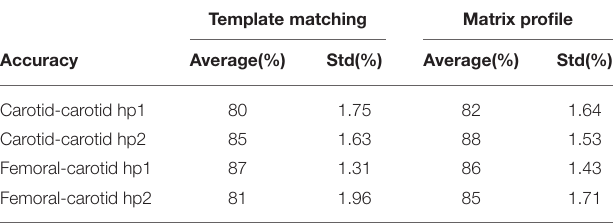
TABLE 4 | The table contains the average performance of the logistic regression models trained on features derived by both template matching and matrix profile